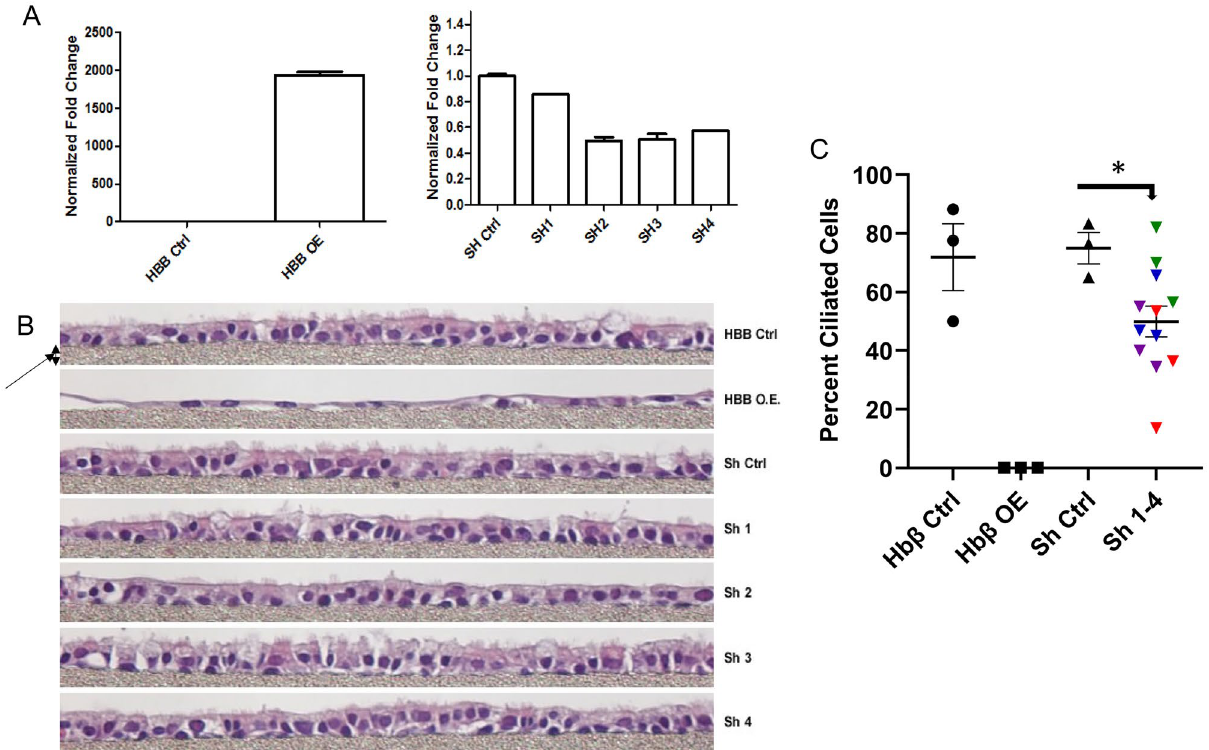
Figure 4. Both hemoglobin β overexpression and hemoglobin β knockdown decrease ALI ciliation. ( A ) RT-PCR analysis of Hbβ mRNA expression in Day 33 ALI primary human bronchial epithelial cells at ALI, transduced with empty vector (Hbβ Ctrl), Hemoglobin β over-expressed vector (Hbβ O.E.), Scrambled Ctrl (SH Ctrl), and Hemoglobin β knockdown shRNA ‘s 1-4 (SH1-4). ( B ) Representative AB-PAS staining of paraffin embedded sections of Day 33 ALI cultures from the Hbβ under- and over-expressing, and control, cells as described in ( A ). 20 × magnification. Arrow shows the membrane thickness that is equal 20 μm. These images were read by three blinded observers each, counting the number of ciliated cells as a fraction of cells on the apex of the culture (see C ). ( C ) Percentage of ciliated apical cells were quantitated blindly by three independent investigators. Cilia were absent from the Hbβ over-expressing cells. In the Hbβ knockdown cells, ciliary expression was decreased relative to wt and scrambled shRNA expressing cells, shown in aggregate (Purple